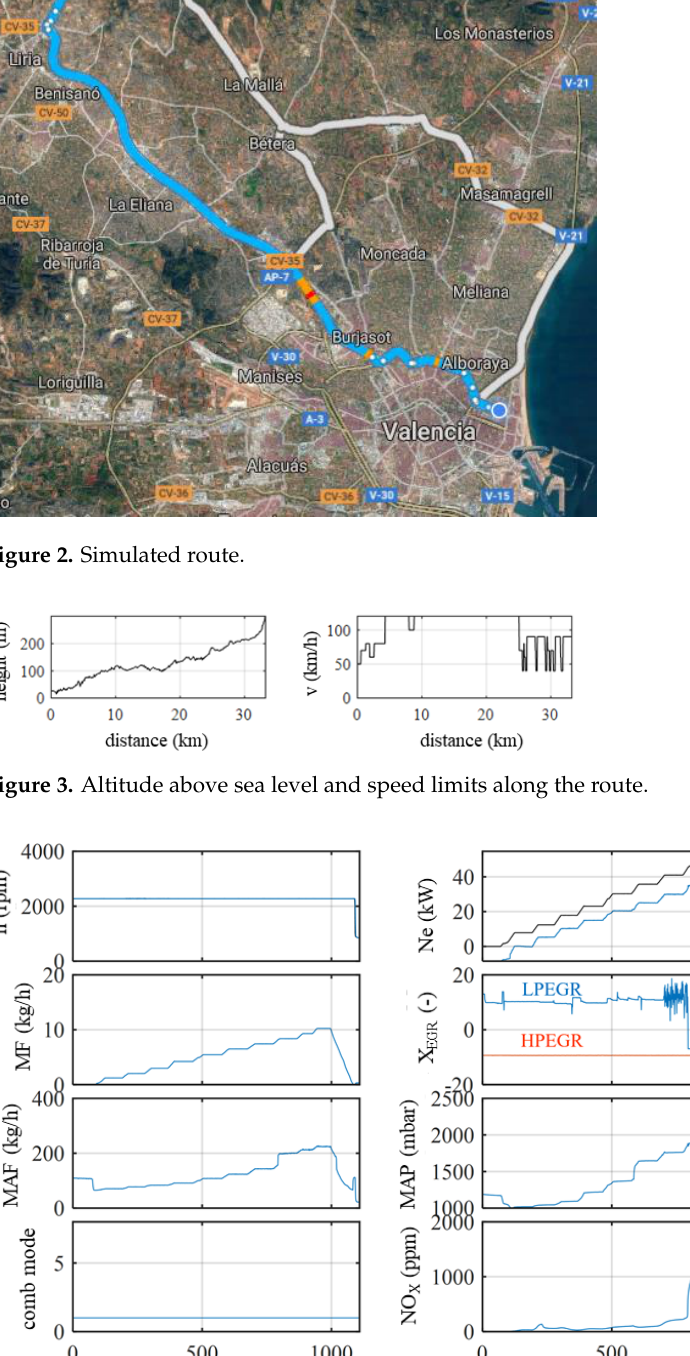
Figure 4. Characterization test at 2250 rpm. The magnitudes showed, from left to right and from top to bottom, are: engine speed, brake power, fuel mass flow, EGR mode (blue, LP-EGR; orange, HP-EGR), air mass flow, air pressure, combustion mode and NOx.